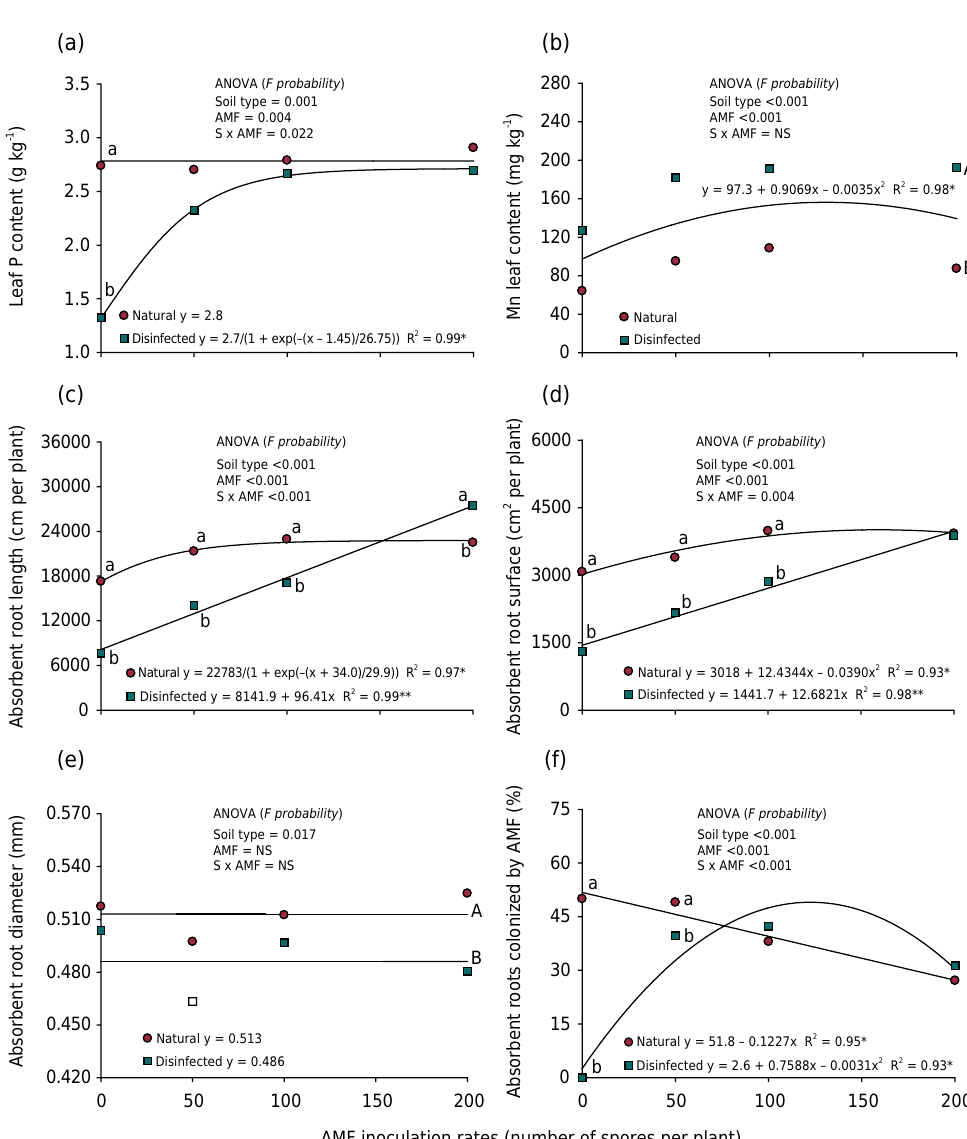
Figure 1. Contents of P (a) and Mn (b) in the leaves, root length (c), root surface (d), root mean diameter (e), and AMF colonization (f) of absorbent roots of the cassava in response to AMF inoculation rates in natural and disinfected soils. Within each AMF inoculation rate, different lowercase letters indicate a significant difference between soil types, whereas the absence of lowercase letters indicates a non-significant difference between soil types at p ≤ 0.05. Different uppercase letters indicate a significant difference between soil types at p ≤ 0.05 regardless of AMF inoculation rate. * p ≤ 0.05; ** p ≤